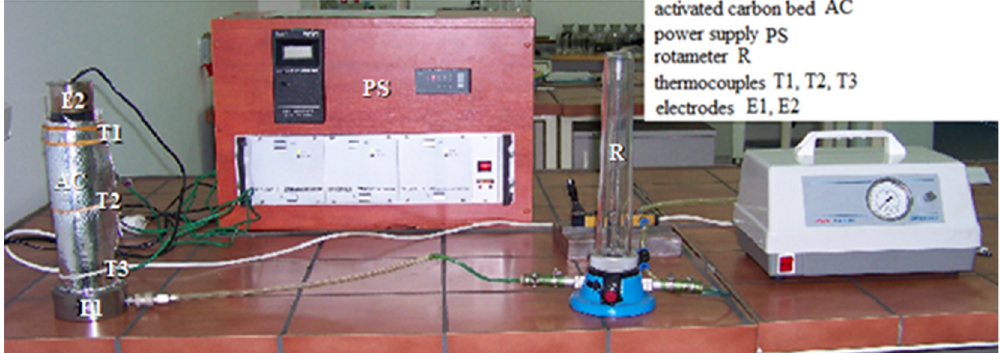
Figure 1. Testing stand for activated carbon modification using Joule heat (SEOW).